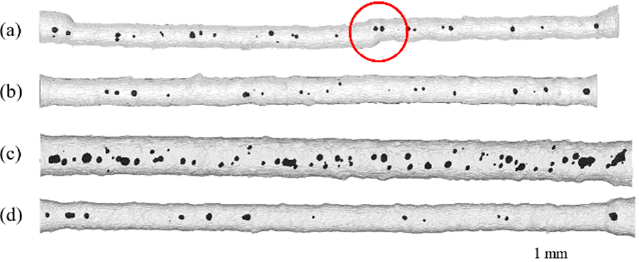
Figure 4. Reconstructed 3D images of µCT scans of ( a ) specimen L1-D with offset defect (red circle), ( b ) specimen C1-B, ( c ) specimen L10-F and ( d ) specimen C1-C showing segmented struts (transparent view) with pores in black.